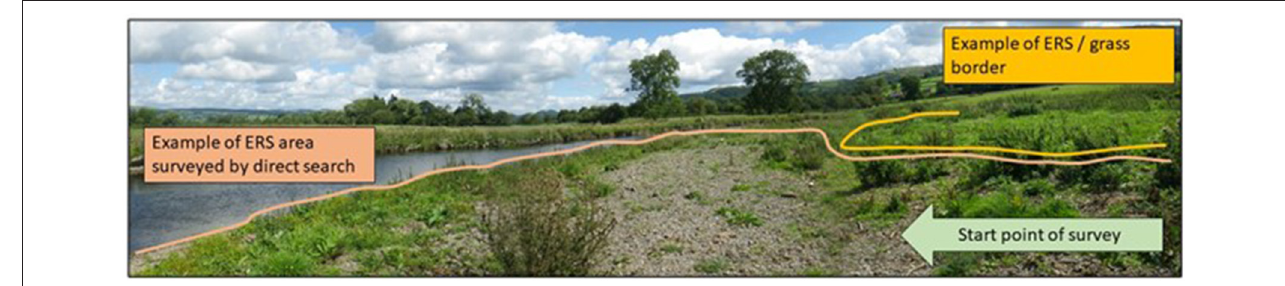
FIGURE 1 | Illustration of a typical site with ERS/shingle bank bordered by grassland/pasture with the start point for direct search highlighted.